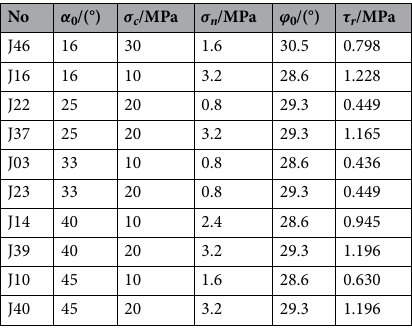
Table 2. Calculation parameters for cyclic shear strength of joints.